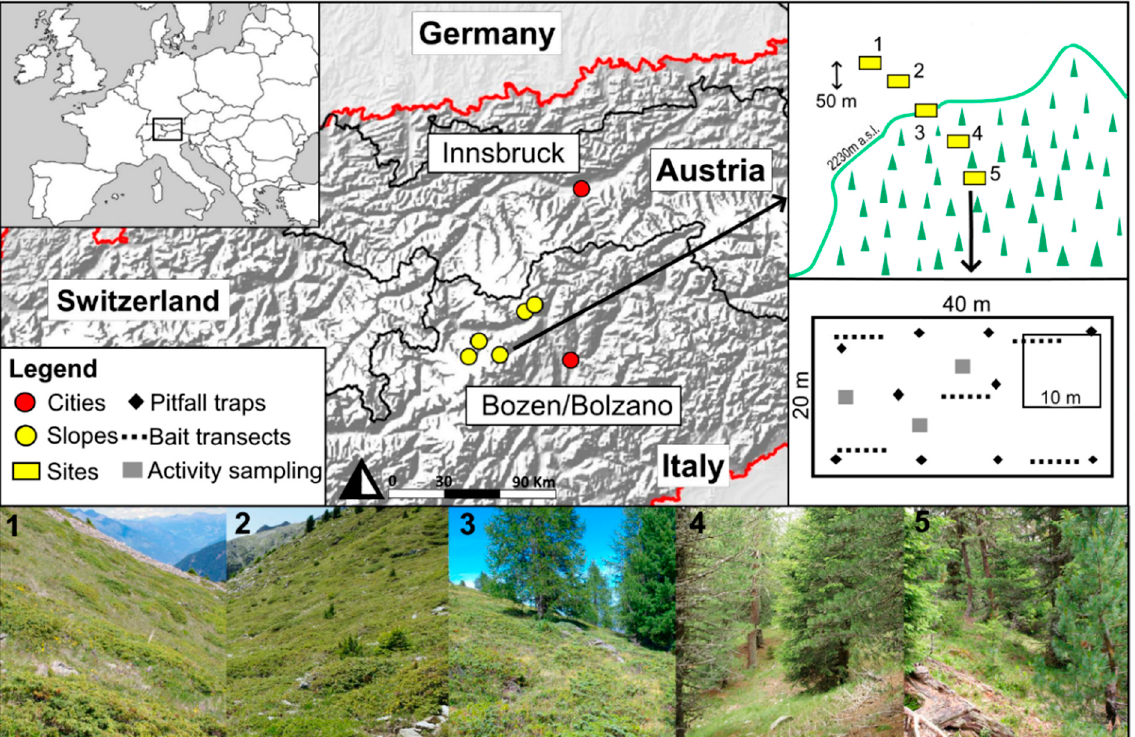
Figure 1. Map of the study sites depicting the five slopes. The inset on top right is an example of the sites’ position within one slope. The numbering of the single sites matches the numbers of the pictures giving an overview about the single sites and the habitats covered by one slope. Numbers 1 and 2 depict the alpine habitat characterized by low vegetation interspersed by dwarf shrubs. Number 3 is an example of the ecotone site. Numbers 4 and 5 depict the forest sites with a denser tree cover. An additional inset (middle right) shows schematically the distribution of all samples taken with five survey methods within each site.